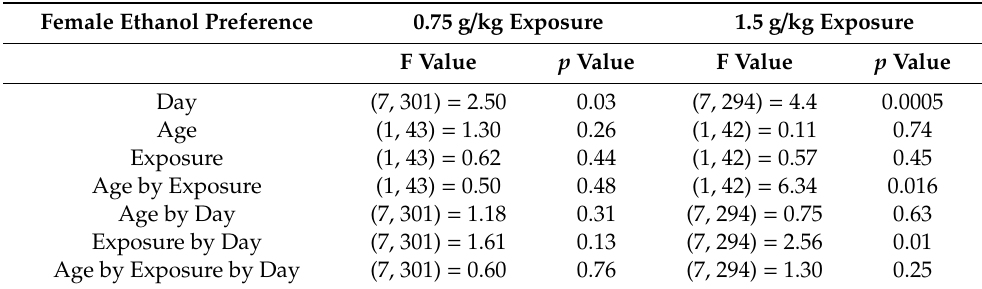
Table 3. Table for ANOVA results for female ethanol preference data.